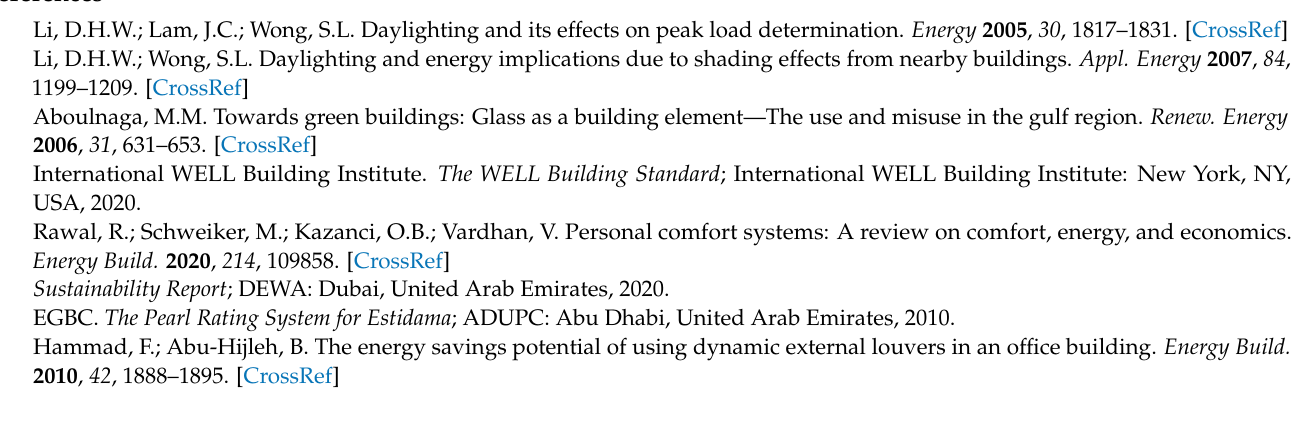
Figure A1. Questionnaire for occupants—indoor air quality (IAQ).